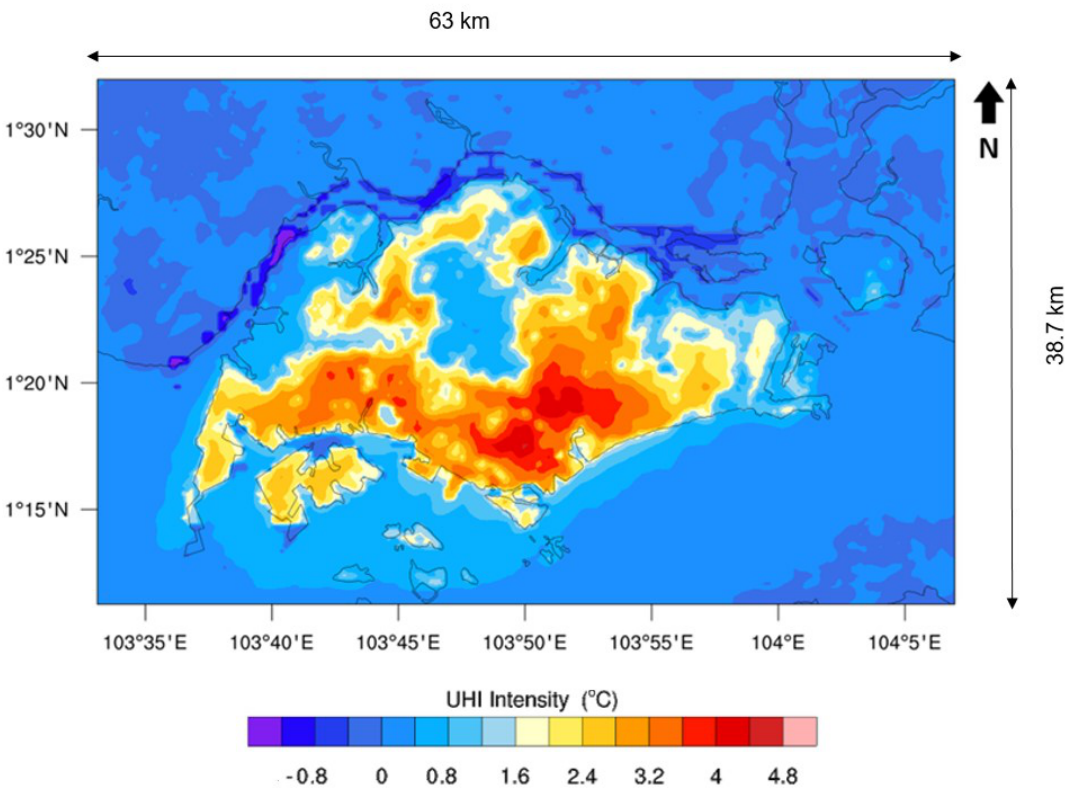
Figure 2. Map of the Urban Heat Island(UHI) situation in Singapore presented to the respondents. (average di ff erence in 2-m temperature between “Control” and “AllGreen” case at 04:00 LT, April 2016—Source: Mughal et al., 2019) [24].